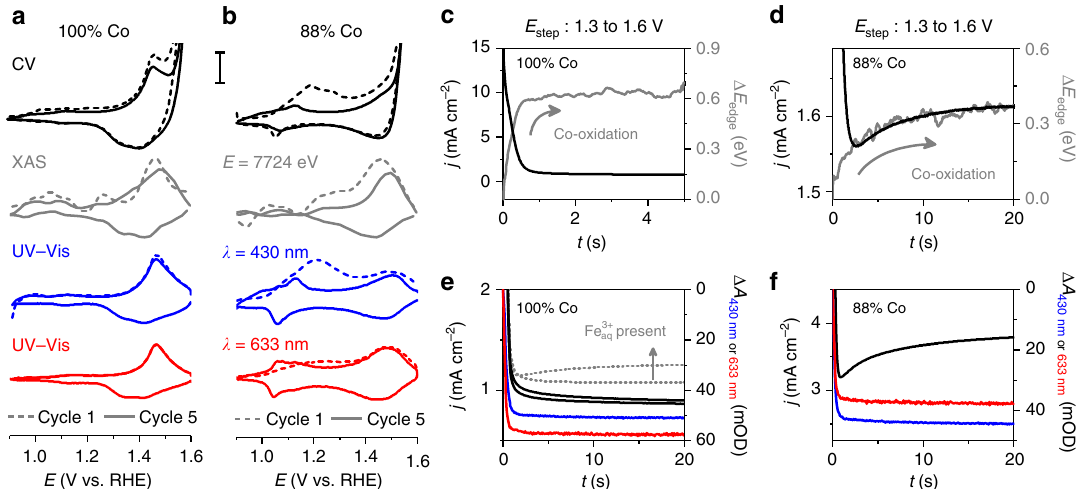
Fig. 4 Spectroelectrochemical behavior of representative Fe – Co oxides. a , b Current density for cyclic voltammetric (CV) experiments and the derivative of spectroscopic signals for in situ X-ray absorption spectroscopy (XAS) and UV – visible spectroscopy (UV – vis) measurements. Scale bar represents 0.2 mA cm − 2 . c , d Comparison of current density and change in Co K-edge location during in situ XAS measurements following anodic potential steps. e , f Comparison of current density and visible light transmittance recorded during anodic potential steps. Current densities and changes in absorbance are shown for the tenth anodic step on electrodes examined in electrolyte solutions that were puri fi ed of Fe 3+ impurities. The fi rst and 10 th anodic potential steps are shown for a 100% Co electrode that was examined in an electrolyte solution that was not puri fi ed of Fe 3+ contaminations